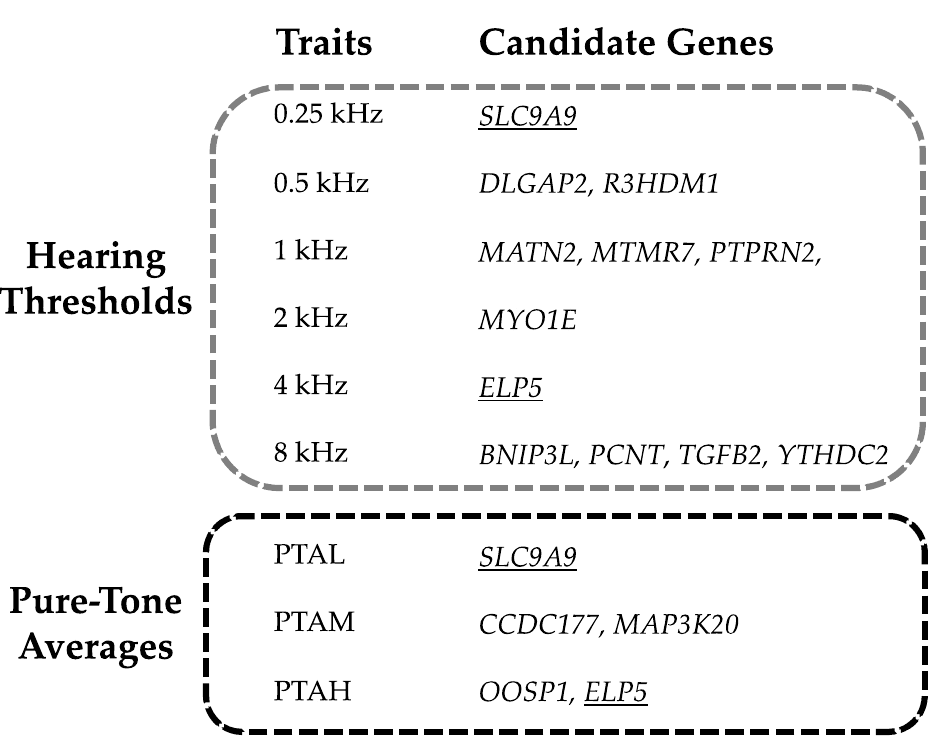
Figure 2. The picture describes the candidate genes for each trait divided in hearing thresholds and Pure-Tone Averages (PTA). The genes found for more than one trait are underlined.